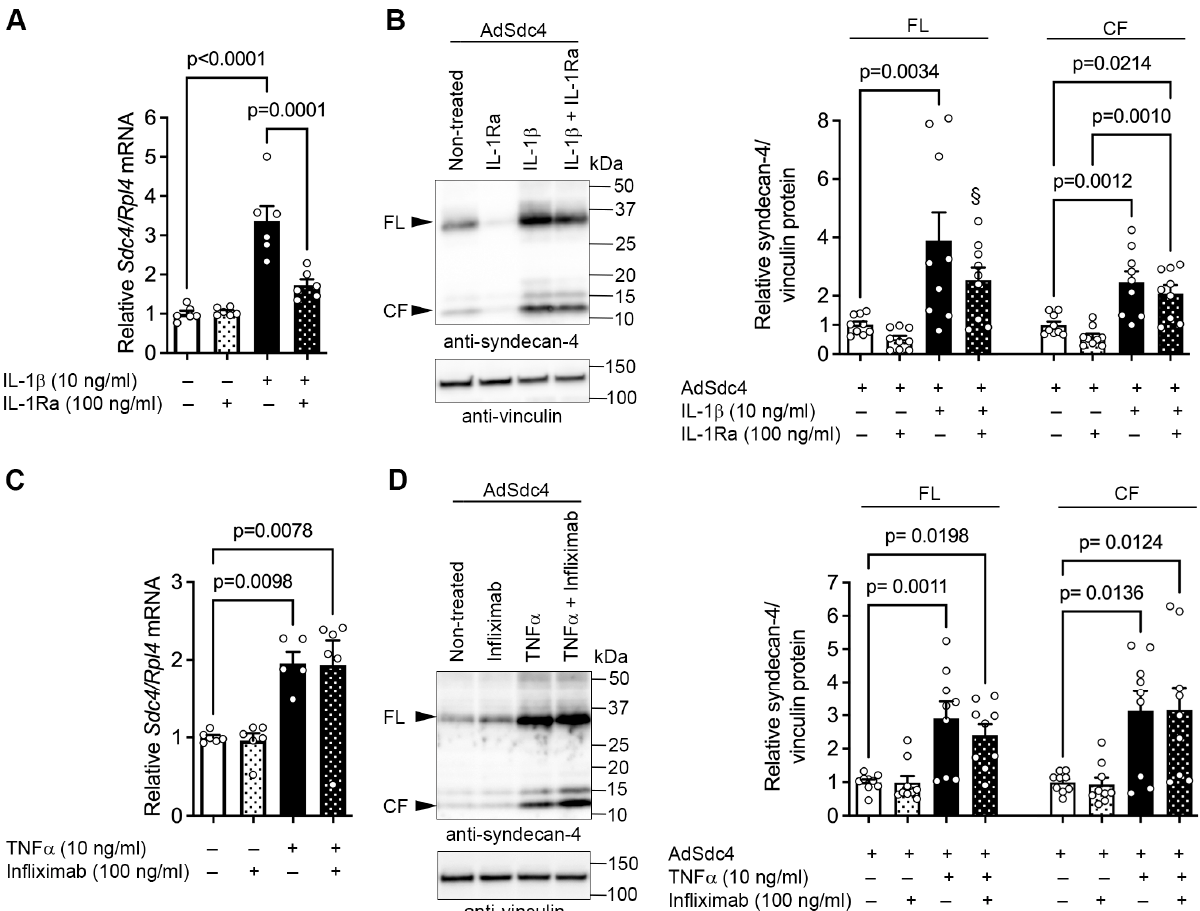
Figure 4. A tt enuation of interleukin 1 β -increased syndecan-4 levels immunomodulatory therapy in cultured cardiomyocytes. Primary cardiomyocyte cultures were prepared from neonatal rat hearts. ( A ) Relative mRNA expression of endogenous rat syndecan-4 (Sdc4) in cardiomyocytes following